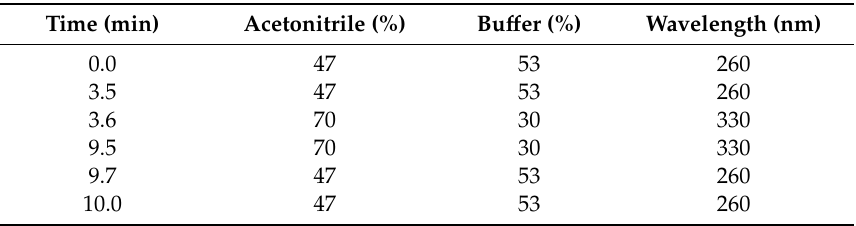
Table 1. Timetable of the validated gradient